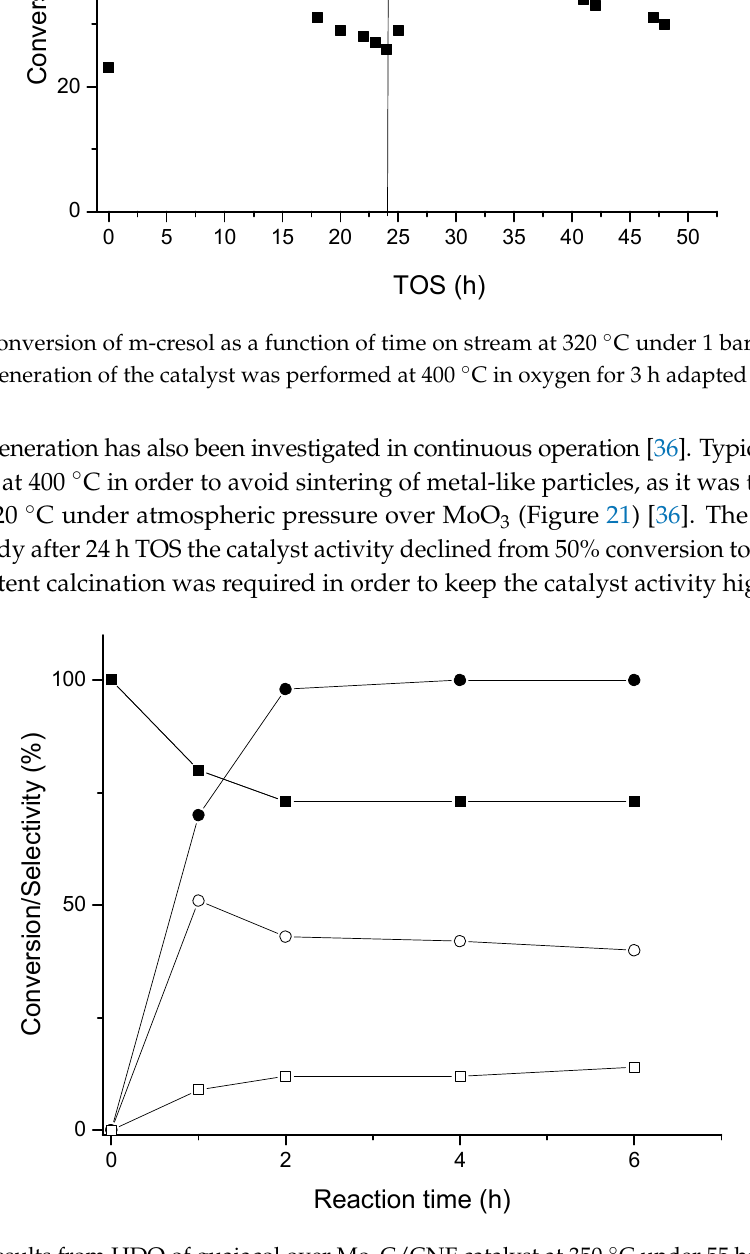
Figure 21. Results from HDO of guaiacol over Mo 2 C/CNF catalyst at 350 °C under 55 bar hydrogen. Symbols: mass balance ( ■ ), conversion ( ● ), phenol (o) and cresol ( □ ) adapted from reference [54].